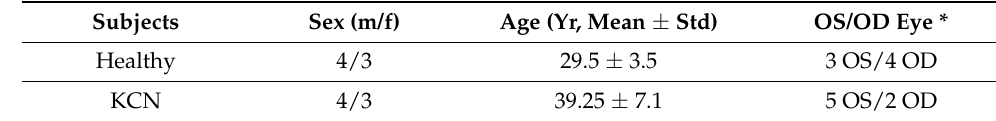
Table 1. General demographic data of the healthy controls and the KCN